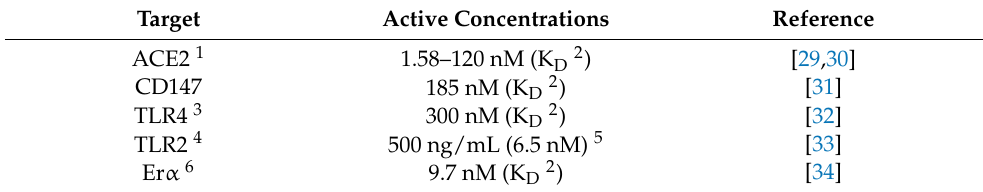
Table 1. Molecular targets of SARS-CoV-2 S